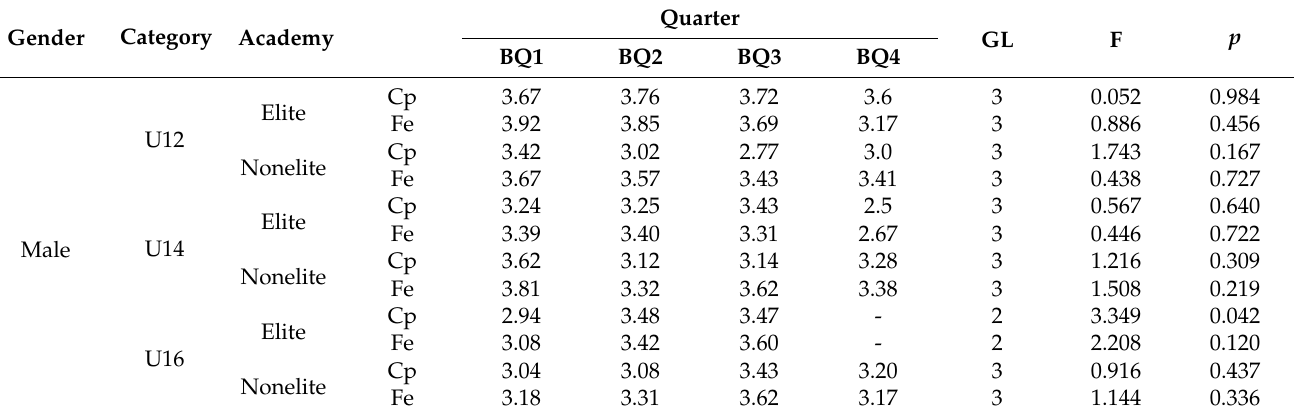
Table 7. Analysis of the coaches’ current and future expectation of success and the